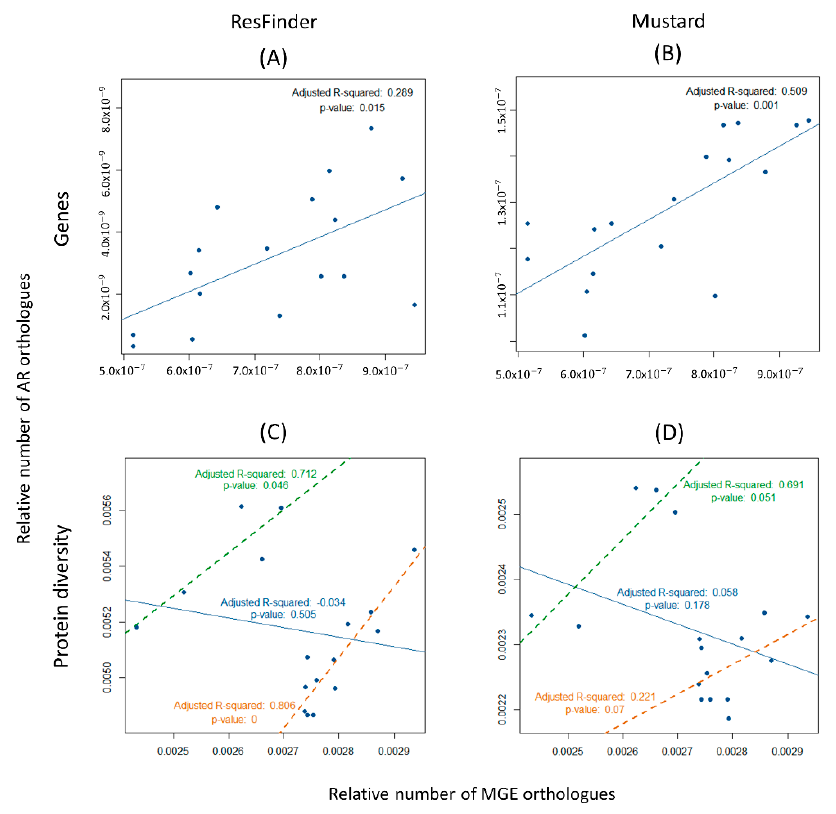
Figure 5. Correlation between antibiotic resistance (AR) orthologues and mobile genetic elements (MGEs) for the Sado River. Each point represents a metagenome. ( A ) Positive correlation between the relative number of antibiotic encoding resistance genes (ResFinder) and MGEs (Adjusted R- squared = 0.289, p -value = 0.015). ( B ) Positive correlation between the relative number of antibiotic encoding resistance genes (Mustard) and mobile genetic elements (Adjusted R-squared = 0.509, p - value = 0.001). ( C ) Negative correlation between the diversity of antibiotic encoding resistance pro- teins (ResFinder) and mobile genetic elements (Adjusted R-squared = − 0.034, p -value = 0.505). The points agglomerate into two distinct clusters, leading to two positive correlations: one identified by the green regression line (Adjusted R-squared = 0.712, p -value = 0.046) and the other identified by the orange regression line (Adjusted R-squared = 0.806, p -value = 0). ( D ) Negative correlation be- tween the diversity of antibiotic encoding resistance proteins (Mustard) and mobile genetic ele- ments (Adjusted R-squared = 0.058, p -value = 0.178). The points agglomerate into two distinct clus- ters, leading to two positive correlations: one identified by the green regression line (Adjusted R- squared = 0.691, p -value = 0.051) and the other identified by the orange regression line (Adjusted R- squared = 0.221, p -value = 0.07).